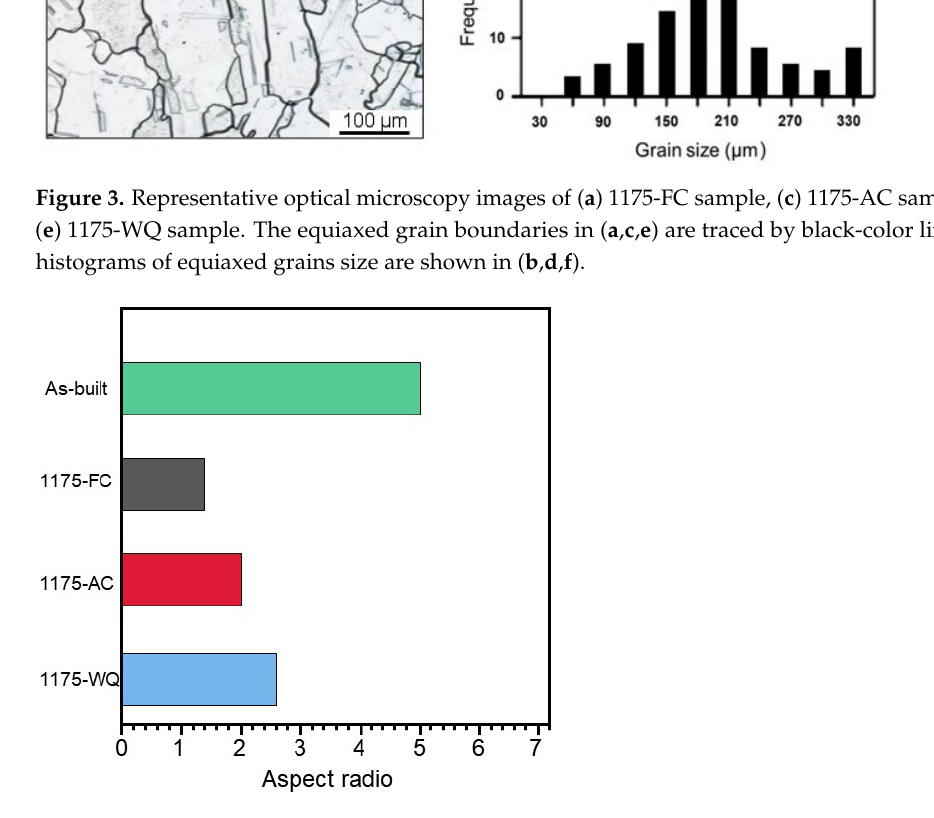
Figure 4. Calculated grain aspect ratio for samples in different states: as-built, 1175-FC, 1175-AC, and